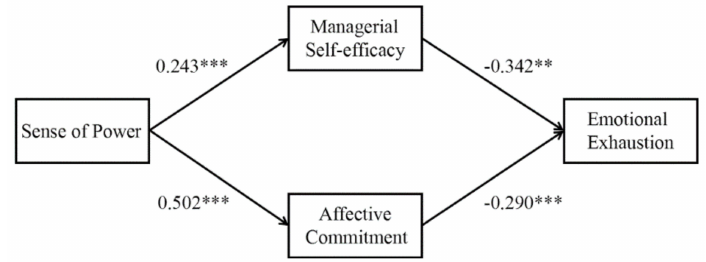
Figure 2. The results of regression in the full mediation model. Notes. * p < 0.05, ** p < 0.01, *** p <